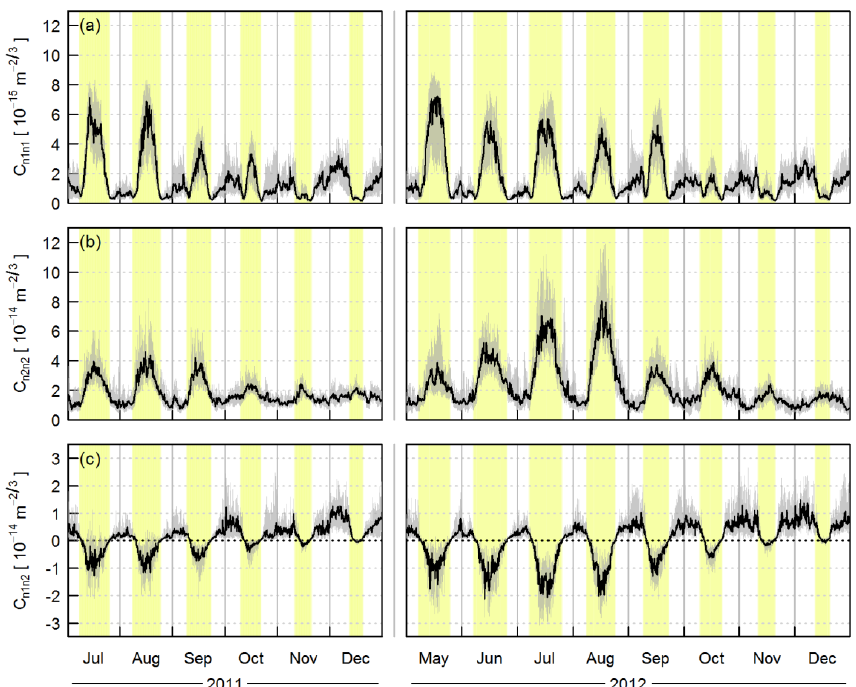
Figure 6. Median diurnal cycles and inter-quartile ranges (grey shading) of the structure parameters of the refractive index as measured by (a) the BLS and (b) the MWS, and (c) the cross-structure parameter as measured by the BLS–MWS combination, separated by month. Yellow shading indicates periods when Q ∗ > 0Wm − 2